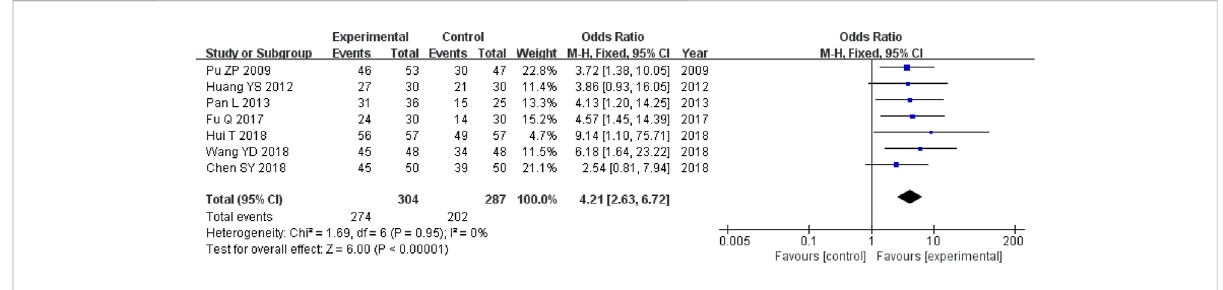
FIGURE 3 Comparativeforestplot:totalclinicaleffectiverate.ThepooledORwas4.21(95%CI2.63 – 6.72, p < 0.00001).Thetotalclinicaleffectiveratewas signi fi cantly higher in the experimental cohort compared with that in the control cohort. OR, odds ratio; CI, con fi dence